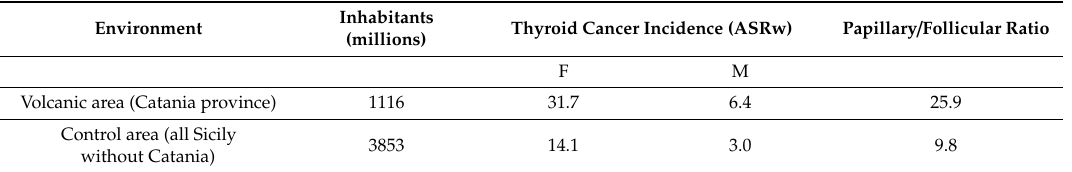
Table 1. Thyroid cancer in Sicily: age-standardized incidence rates for the world population (ASRw) in the volcanic and the control areas and the papillary / follicular histotypes ratio. Data from